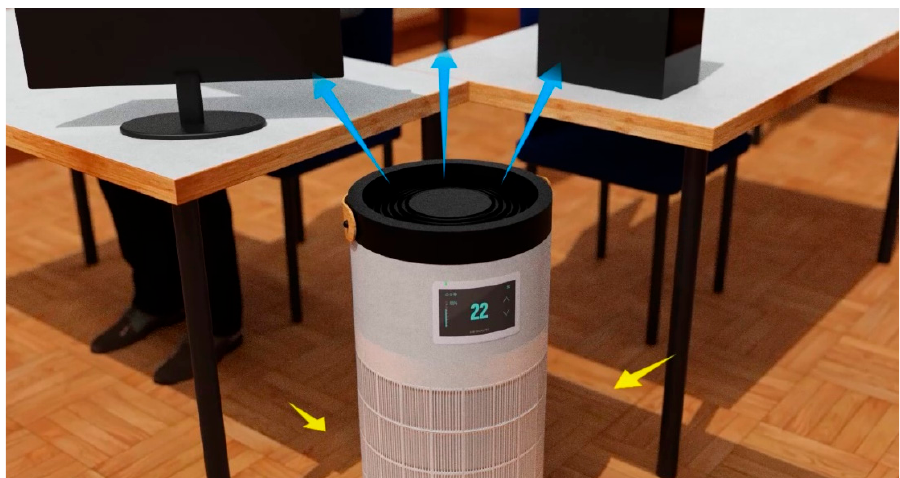
Figure 3. Rendered CFD visualization of the two air cleaning devices in the room. The airflow to the device is shown in yellow and the filtered airflow away from the device in blue.